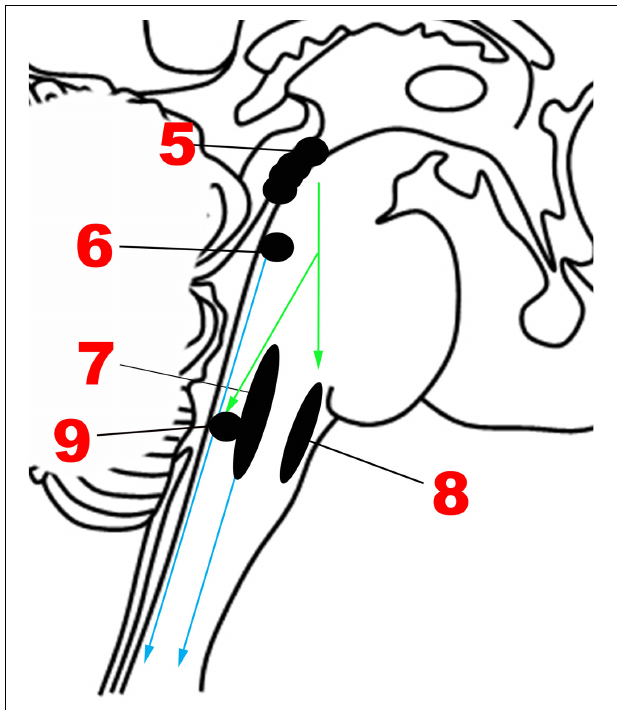
FIGURE 4 | Major structures involved in the Descending network. (5) Periaqueductal gray. (6) Locus coeruleus. (7) Caudal raphe nuclei. (8) Rostral ventrolateral medullary nuclei. (9) Dorsal motor nucleus of the vagus nerve. Green arrows: Descending projections from periaqueductal gray. Blue arrows: Descending projections from the caudal raphe and locus